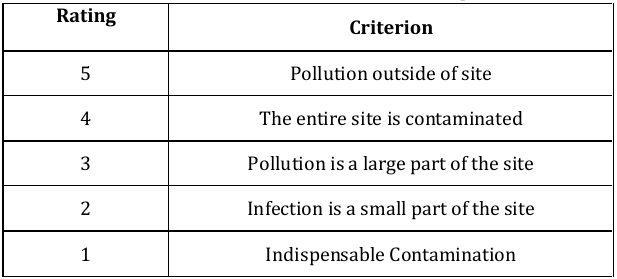
Table 1: Extent of the environmental aspect